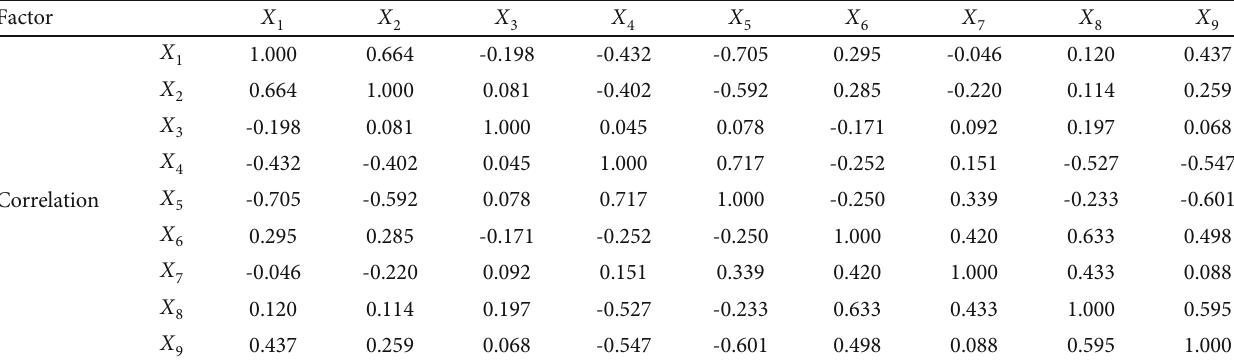
Table 2: Correlations of various factors.